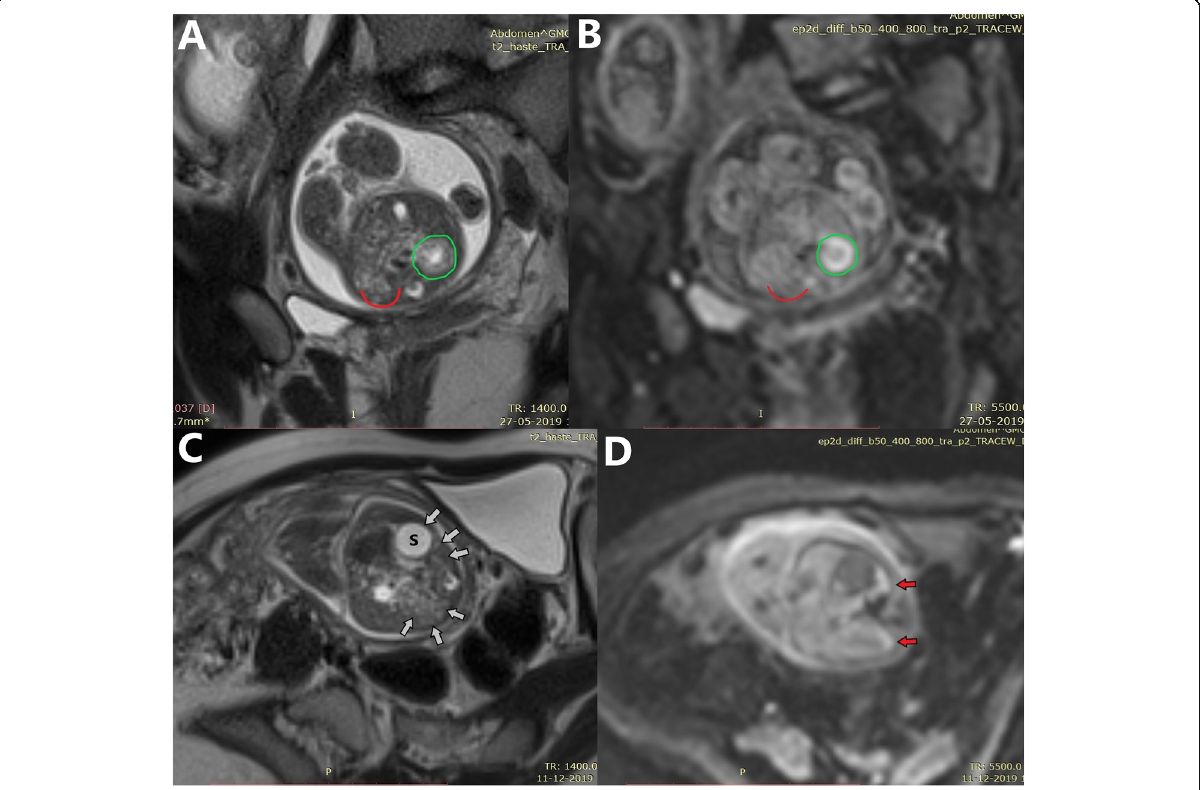
Fig. 7 a , b Unilateral renal agenesis: maternal age: 25 years; period of gestation: 24 weeks 2 days; T2 HASTE axial ( a ) and DWI axial ( b ) show one normal fetal kidney with bright DWI signal (green tracing) while the on contralateral side the renal fossa is empty and bright DWI signal is missing (red arc). c , d Bilateral renal agenesis: maternal age: 21 years; period of gestation: 25 weeks 4 days; T2 HASTE axial ( c ) and DWI axial ( d ): bilateral renal fossae are empty (arrows) with absent DWI bright signal in bilateral renal fossae (red arrows); urinary bladder was not visualized.